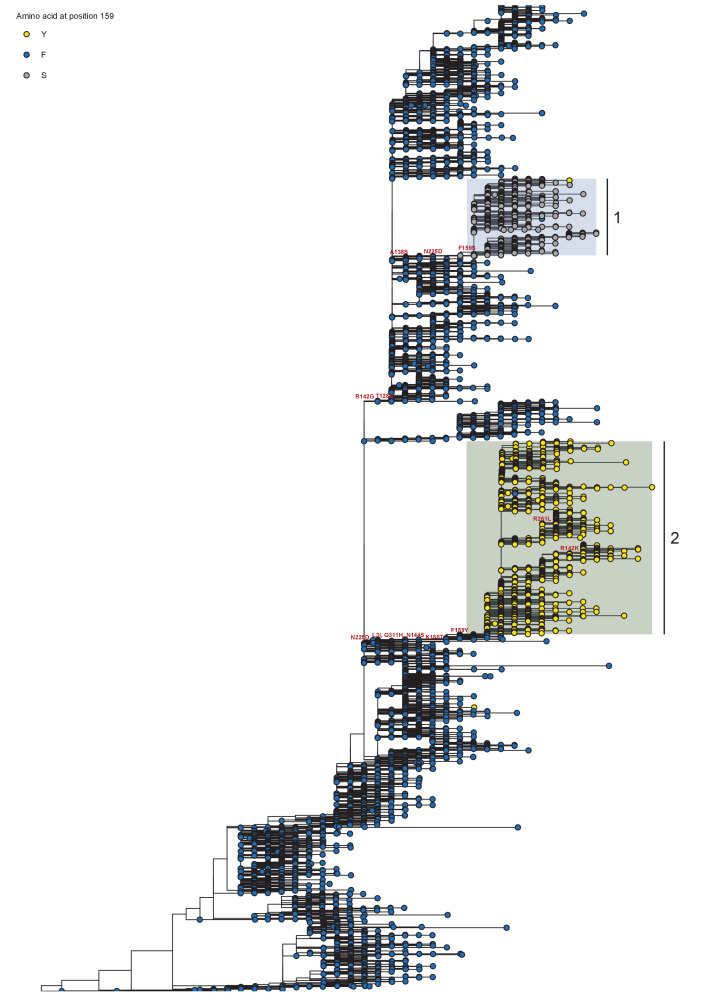
Phylogeny of A/H3N2 seasonal viruses for the period 2012 to 2014.Branch tip color indicates the amino acid identity at position 159. Co-circulating lineages defined by the F159X fixation are highlighted. Scale bar indicates the number of nucleotide substitutions per site. Tree is rooted to A/Perth/16/2009.